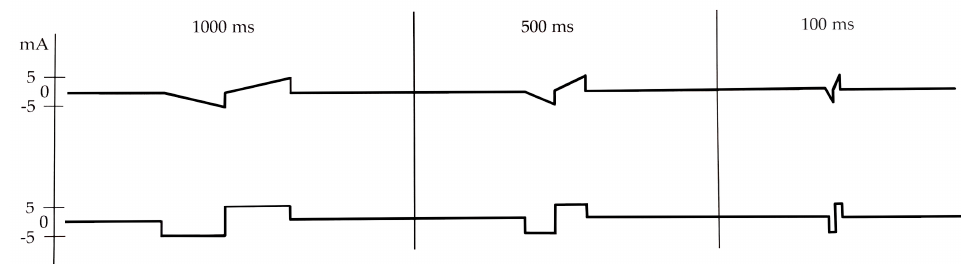
Figure 2. Biphasic single pulse stimulation pattern with a PW of 1000, 500 and 100 ms, delivered with triangular (above) or rectangular waveform (below). ms = milliseconds; mA = milliampere.